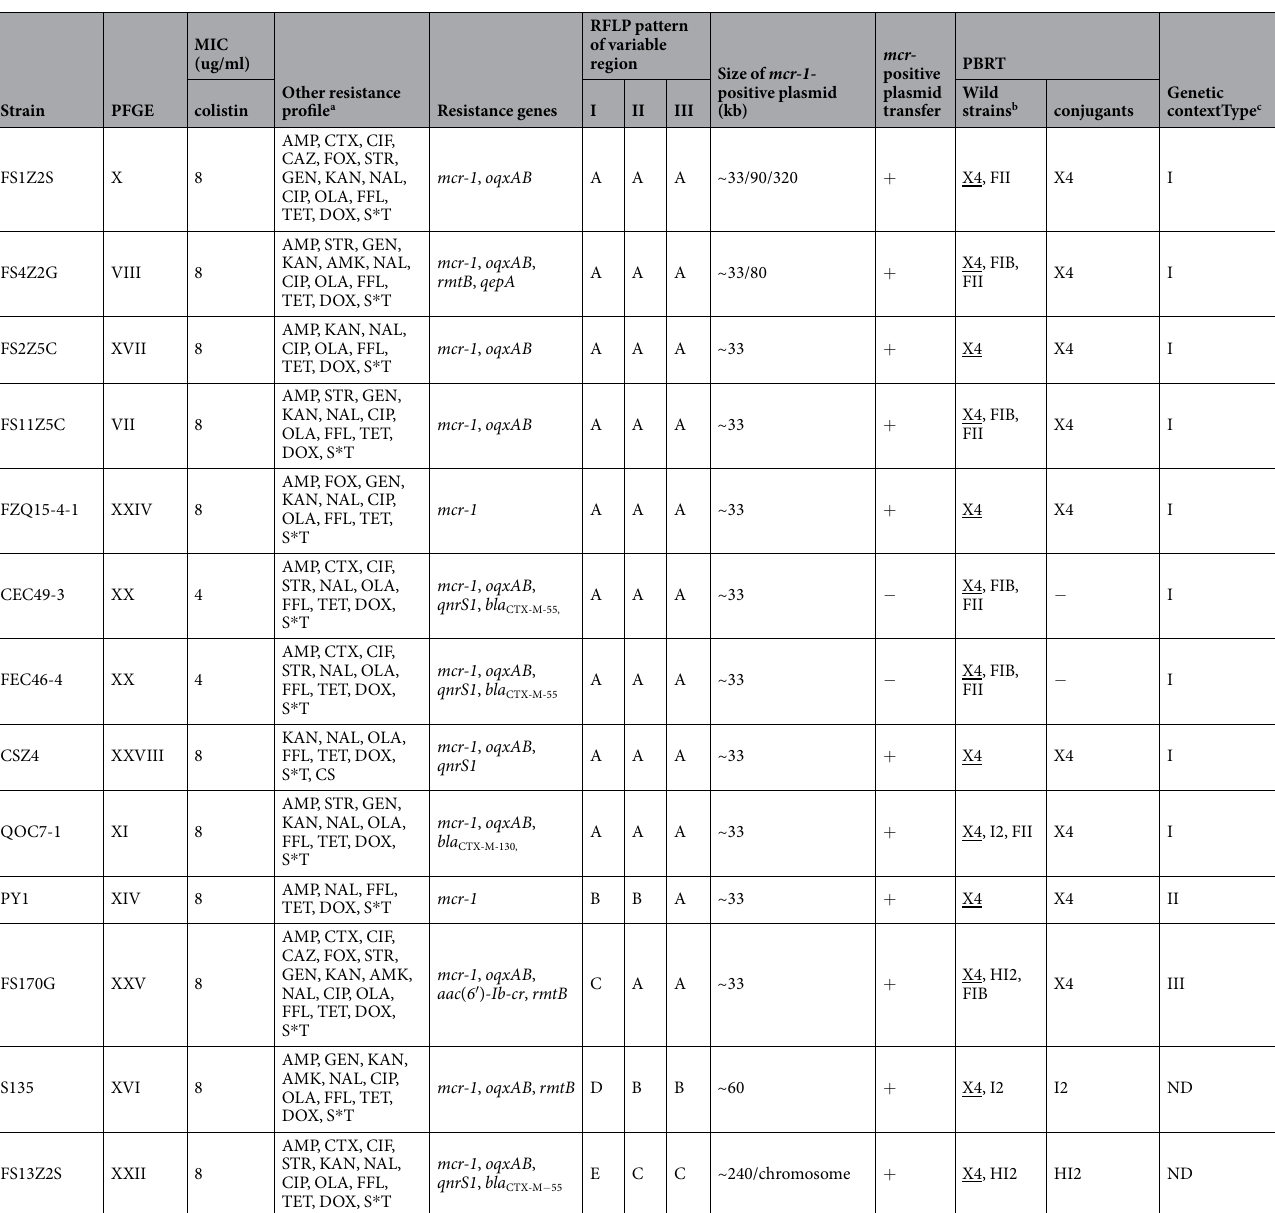
Table 1. Characteristics of the 13 mcr -positive E. coli i solates harbouring IncX4 plasmids. a AMP, Ampicillin; CTX, cefotaxime; CIF, ceftiofur; FOX, cefoxitin; STR, streptomycin AMK, amikacin; GEN, gentamicin; KAN, kanamycin; NAL, nalidixic acid; CIP, ciprofloxacin; OLA, olaquindox; FLF, florfenicol; TET, tetracycline; DOX, doxycycline; S * T, sulfamethoxazole/trimethoprim; CS, Colistin; b “ − ”, transfer of mcr-1 was failure in strains CEC49-3 and CEC49-3; c “ND”, not